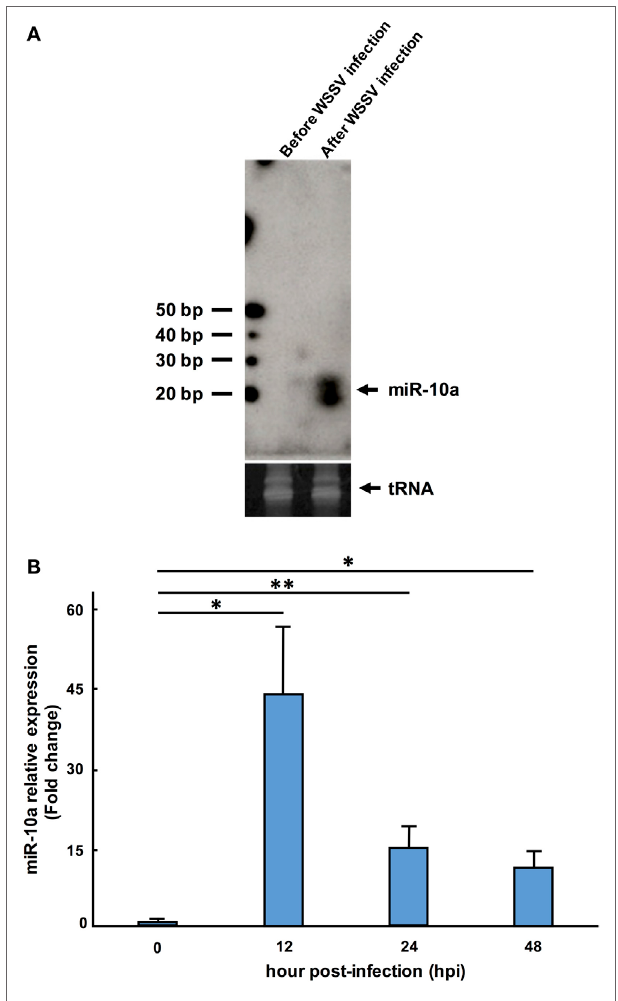
FigUre 1 | Expression level of miR-10a after white spot syndrome virus (WSSV) infection. (a) Northern blot of shrimp miR-10a. Total RNA extracted from shrimp stomach before WSSV infection (0 dpi) and after WSSV infection (48 dpi) was blotted with γ [ 32 P]-labeled miR-10a probe (upper panel). tRNA was used as a loading control (lower panel). (B) Real-time PCR analysis of the expression of miR-10a at 0, 12, 24, and 48 hpi in shrimp stomach. 2 −ΔΔ Ct was used to analyze the expression of miR-10a relative to the expression of shrimp U6 (internal control). Data are presented as mean ± SD from three shrimp at each time point (* p < 0.05 and ** p < 0.01 by Student’s t